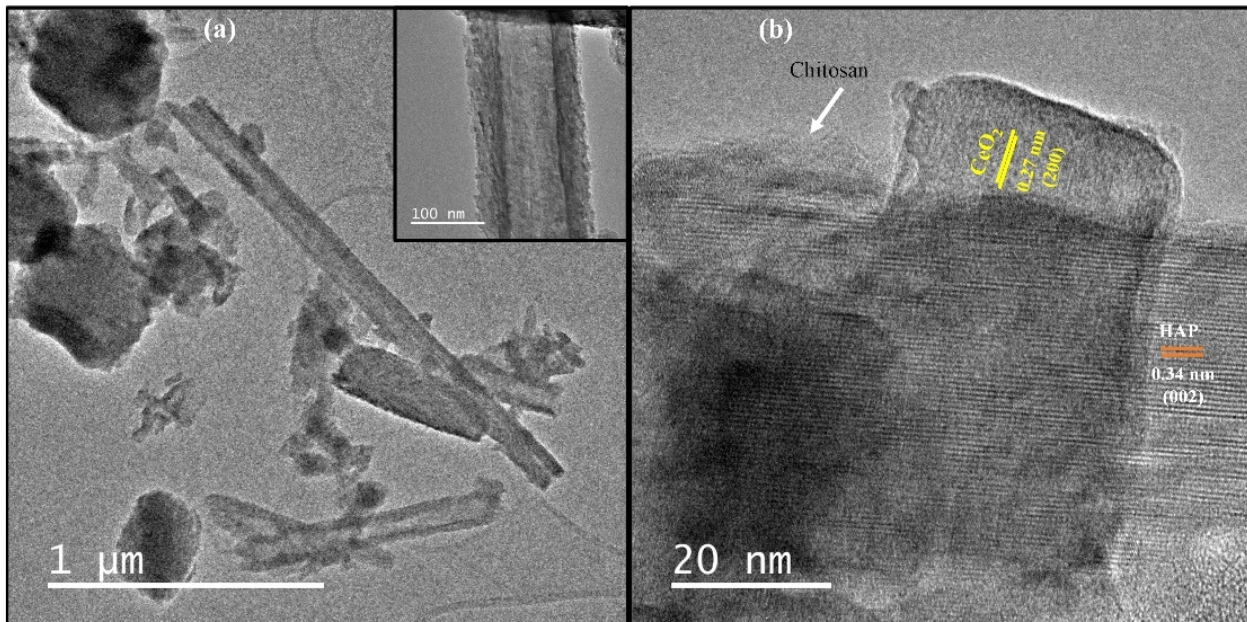
Figure 3. The ( a ) TEM (inset shows single nanotube) and ( b ) HR-TEM images of CS-HAP-CeO 2 heterostructure.